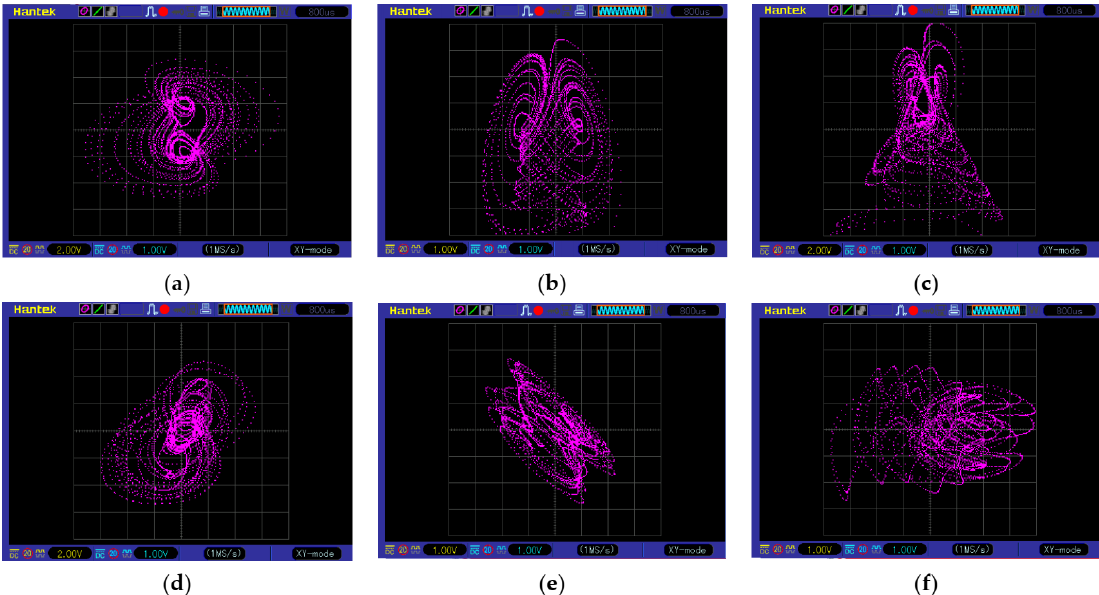
Figure 6. Electronic circuit implementation of system (11): ( a ) phase plane x versus y ; ( b ) phase plane x versus z ; ( c ) phase plane y versus z ; ( d ) phase plane x versus w ; ( e ) phase plane y versus w ; ( f ) phase plane z versus w